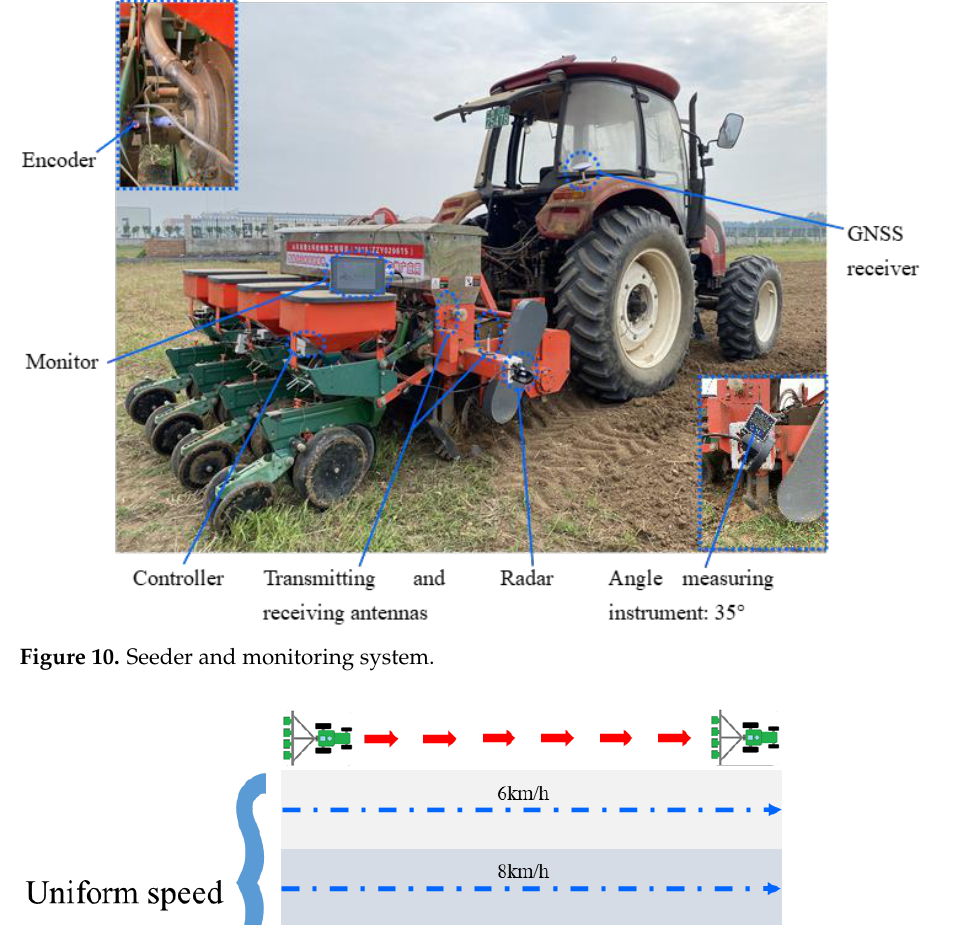
Figure 10. Seeder and monitoring system.